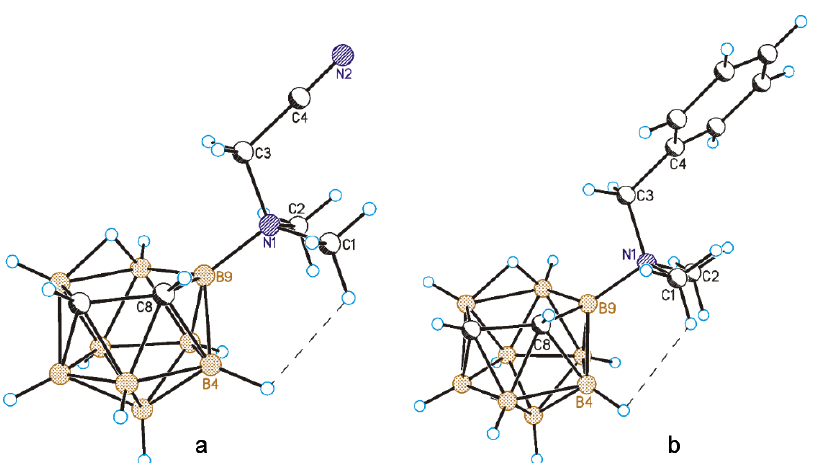
Figure 2. Molecular view of 9- NC≡CCH 2 Me 2 N- nido -7,8-C 2 B 9 H 11 ( a ) and 9-PhCH 2 Me 2 N- nido -7,8- C 2 B 9 H 11 ( b ). Only necessary numbering is provided. Shortened H4…H1A contacts are shown by dashed lines. Table 1. Torsion angles (degree) and shortened H…H contacts (Å) defining the orientation of side substituents relative to the carborane cage for the compounds 9-Me 2 N(CH 2 ) 2 Me 2 N- nido -7,8-C 2 B 9 H 11 4 , 9-NC ≡ CCH 2 Me 2 N- nido -7,8-C 2 B 9 H 11 and 9-PhCH 2 Me 2 N- nido -7,8-C 2 B 9 H 11 . Torsion Angle or H . . .